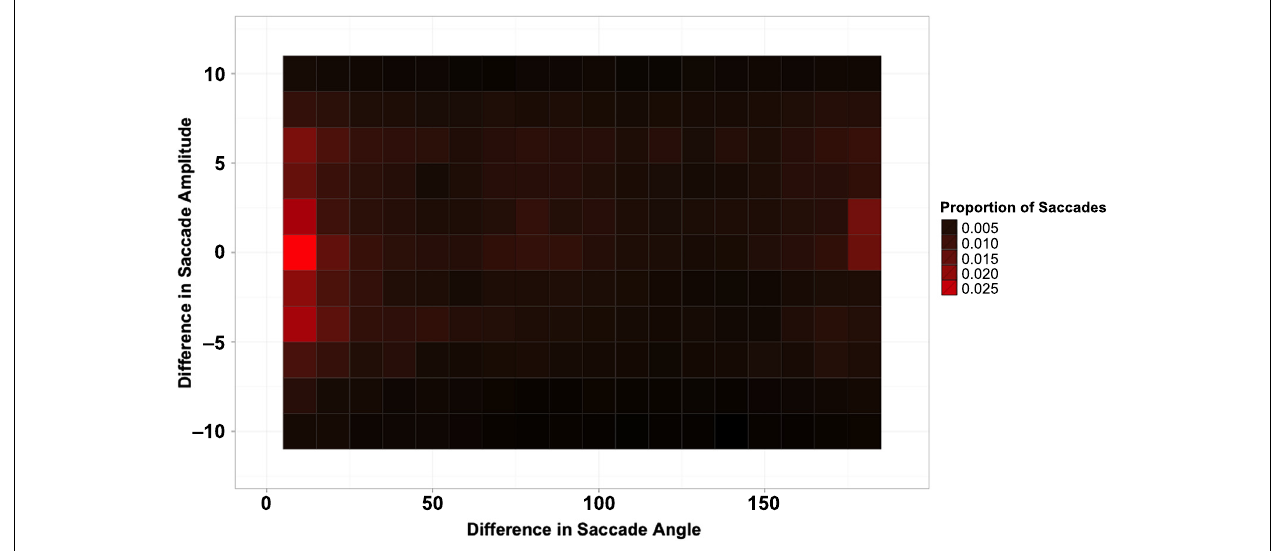
FIGURE 2 | Proportion of saccades as a function of the difference in amplitude ( y -axis) and angle ( x -axis) between the previous saccade and the current one.